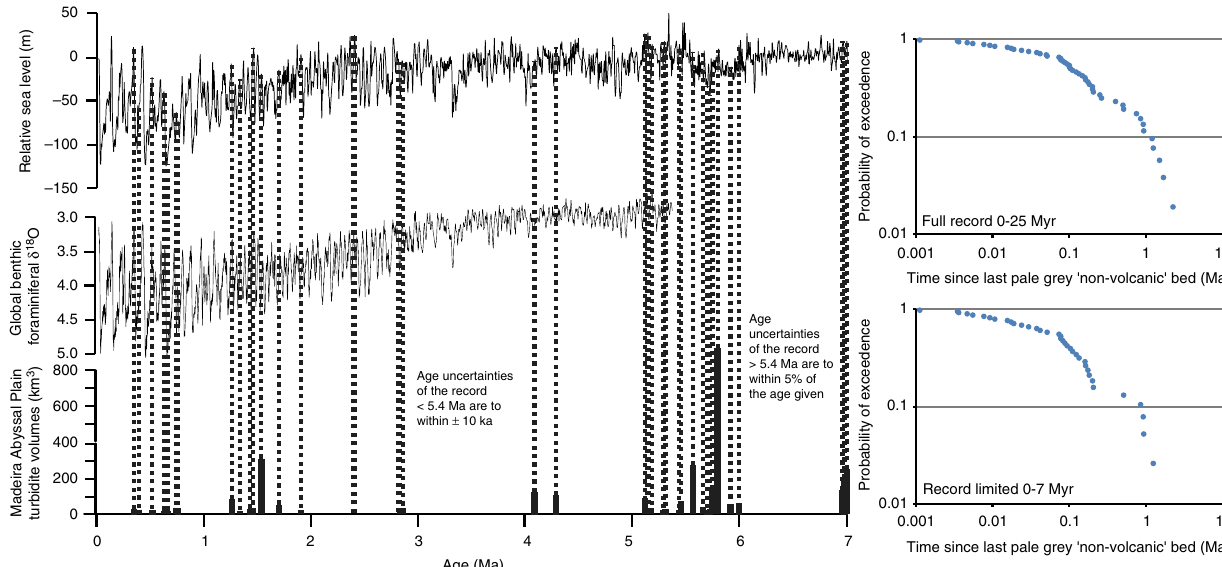
Fig. 7 Comparison of the timing of pale-grey non-volcanic turbidites. Comparison of turbidite is since 7.0 Ma with a relative sea-level curve 76 . In addition, log – log plots of the probability of exceedance of the timing between turbidite events showing a near, but not perfect, exponential distribution de fi ned by a series of linear distributions